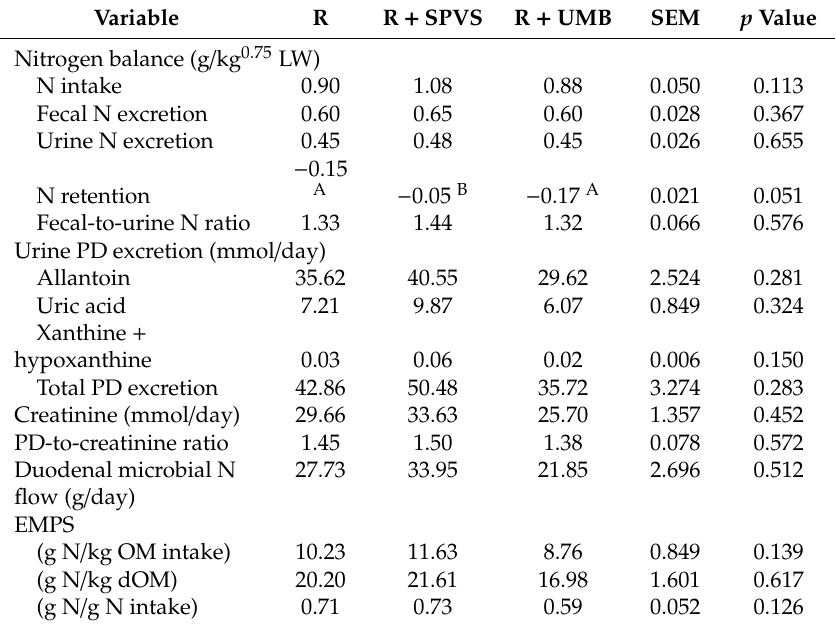
Table 5. Nitrogen (N) balance, excretion of purine derivatives (PD), duodenal microbial N flow, and e ffi ciency of rumen microbial protein synthesis (EMPS) in heifers fed with roughage (R) 1 alone or supplemented with sweet potato vine silage (R + SPVS) and urea-molasses blocks (R + UMB). Variable R R + SPVS R + UMB SEM p